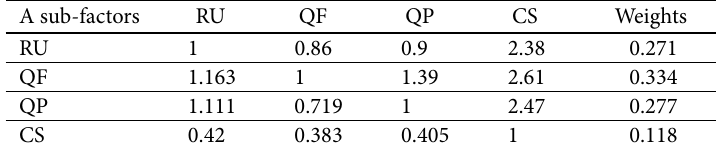
Table 5. Local weights and pairwise comparison matrix of academic sub-factors